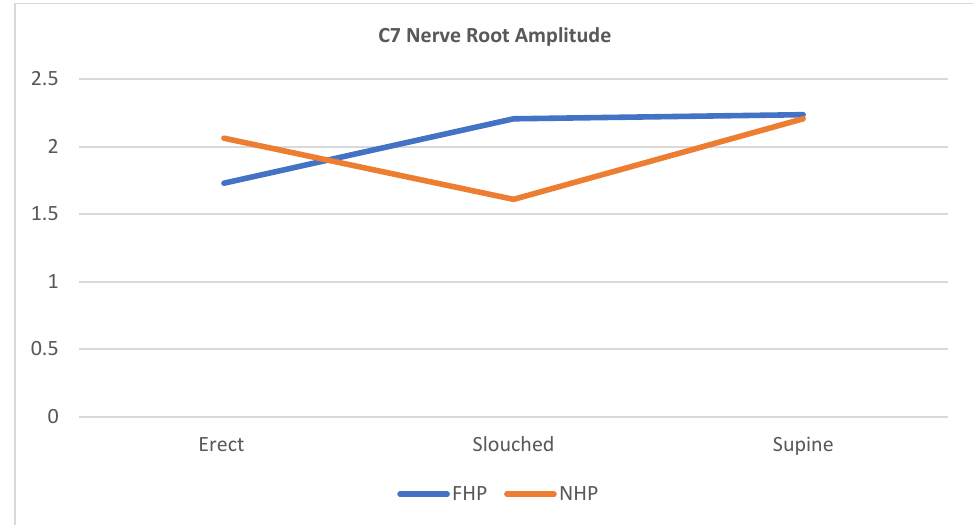
Figure 7. Scatterplot line of cervical nerve C6 amplitude relationship with the different sitting posi- tions for participants with forward head posture (FHP) and normal head posture (NHP). The graph highlights that the FHP group has shown an increased amplitude during slouched sitting compared to erect sitting. The supine position shows the highest nerve peak from all three positions.